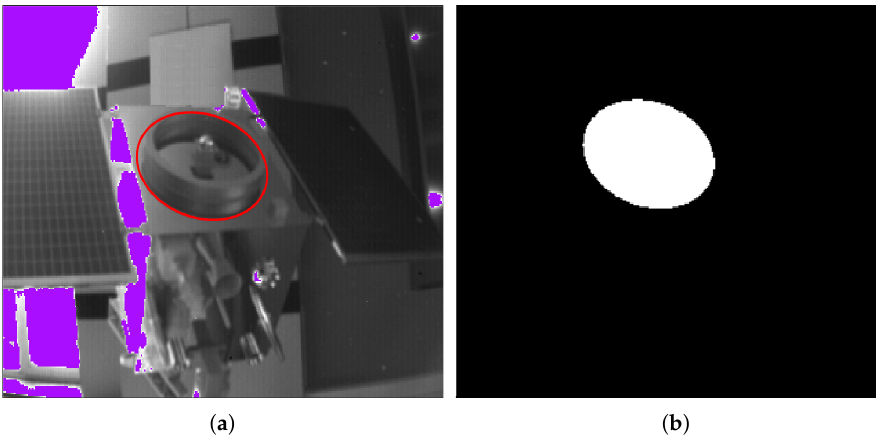
Figure 12. ( a ) The result of ellipse detection; ( b ) the region of interest.